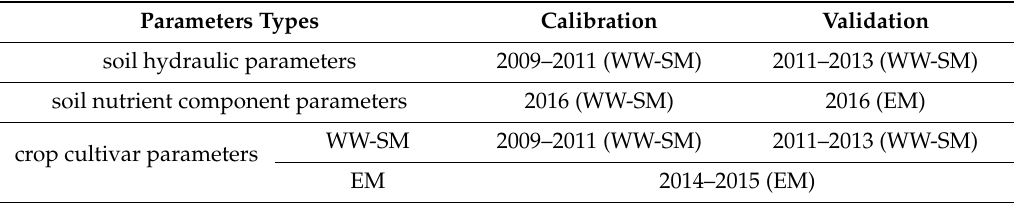
Table 3. The process of the RZWQM2 model calibration and